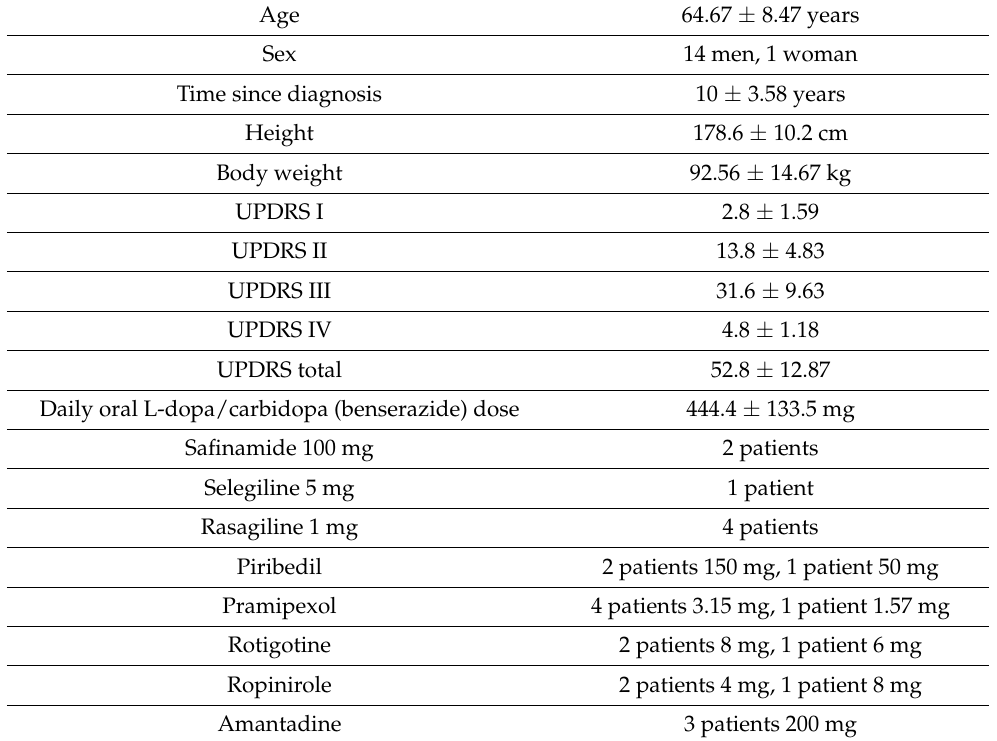
Table 1. Clinical data of the patient group. All data are given as mean ± standard deviation. UPDRS I, Unified Parkinson’s Disease Rating Scale mental behaviour; UPDRS II, UPDRS activities of daily living; UPDRS III, UPDRS motor examination; UPDRS IV, UPDRS motor complications; UPDRS total, sum of UPDRS I, II, III and